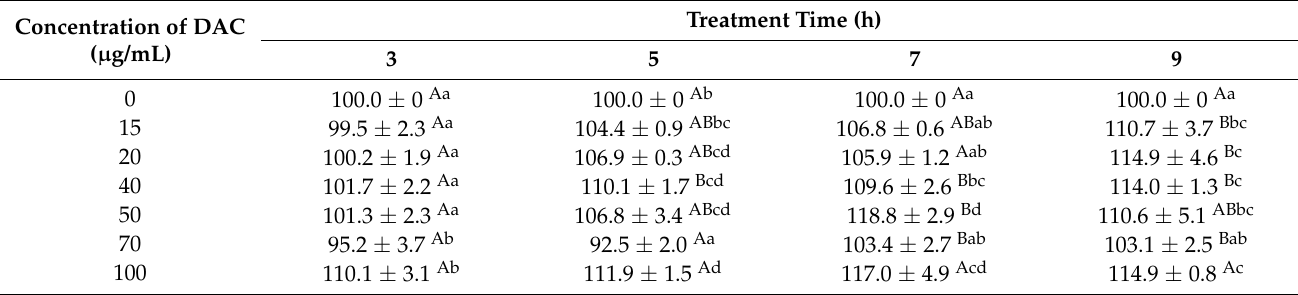
Table 8. The effect of DAC on relative survival rate of GMEC (%).